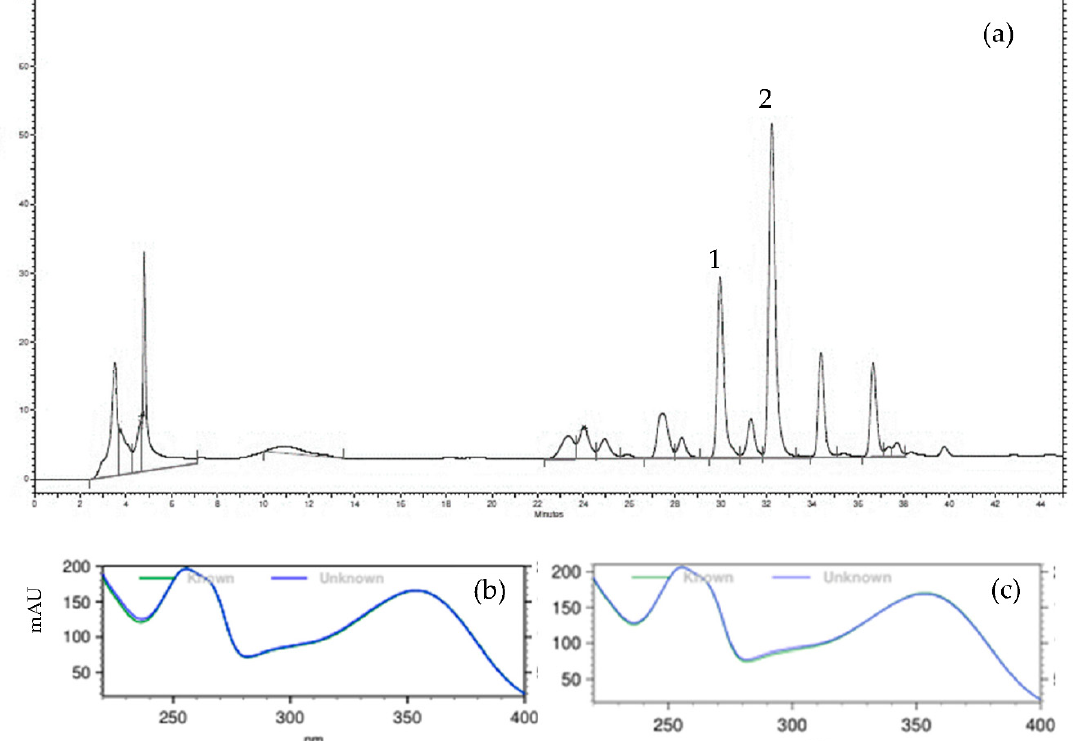
. Figure 3. Cytotoxicity of hydroethanolic extract of Morus nigra leaves in HeLa cells. Data represent the mean of three experiments performed in triplicate ± standard deviation. Vehicle: DMEM with 2% of ethanol. Statistical analysis was performed by one-way ANOVA test followed by Tukey’s post-test. * p < 0.005 in relation to the vehicle. 2.3. Activation of Nuclear Receptors PPAR- γ and PPAR- α The nuclear receptor activation was evaluated by the Luciferase reporter assay. The activation of PPAR- γ by the extract was compared to a full agonist of PPAR- γ control, rosiglitazone, an anti-diabetic drug. The HEMNL at concentrations of 200, 300, and 400 µg/mL was as effective as rosiglitazone in activating the PPAR- γ receptor ( p > 0.005) (Fig- ure 4a). The cells treated with the extract at the concentration of 400 µg/mL showed cell death, above the expected, observed under the microscope. Which may have been caused by the greater sensitivity of the cells when they are transfected. This may explain the re- duction in receptor activation for this extract concentration.